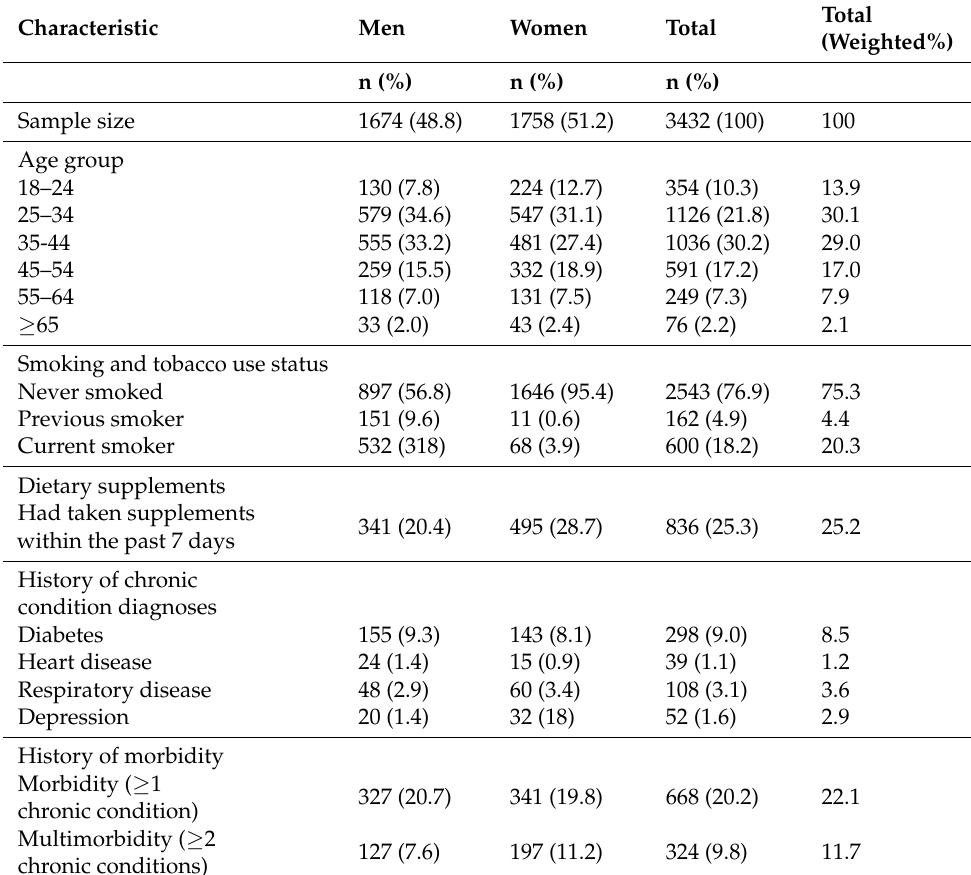
Table 1. Demographic and health characteristics of the study participants.